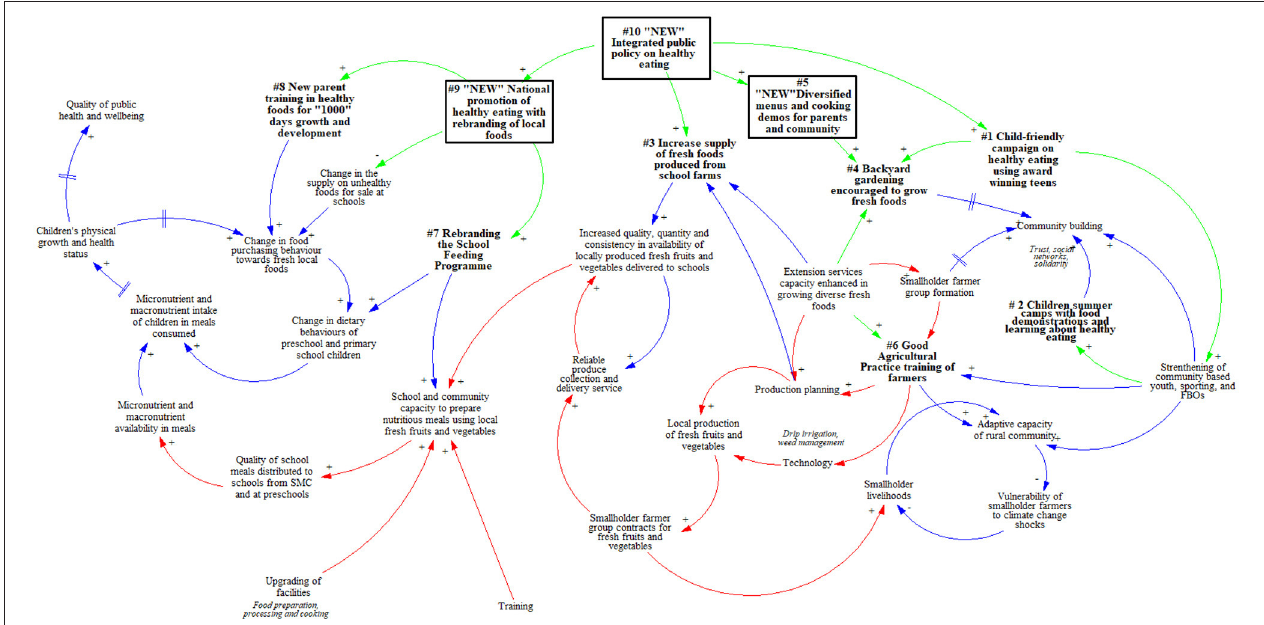
FIGURE 2 | Stakeholder-driven causal map showing a revamped and expanded theory of change (RToC), linking ten newly proposed interventions (green arrows) to F2F interventions (red arrows) and to anticipated outcomes (blue arrows) of the RToC. Double parallel lines indicate time delays in achieving anticipated outcomes. New interventions are placed in a black box, while all other proposed interventions build on existing local programs. FBO, faith-based organizations; SM, School Meals